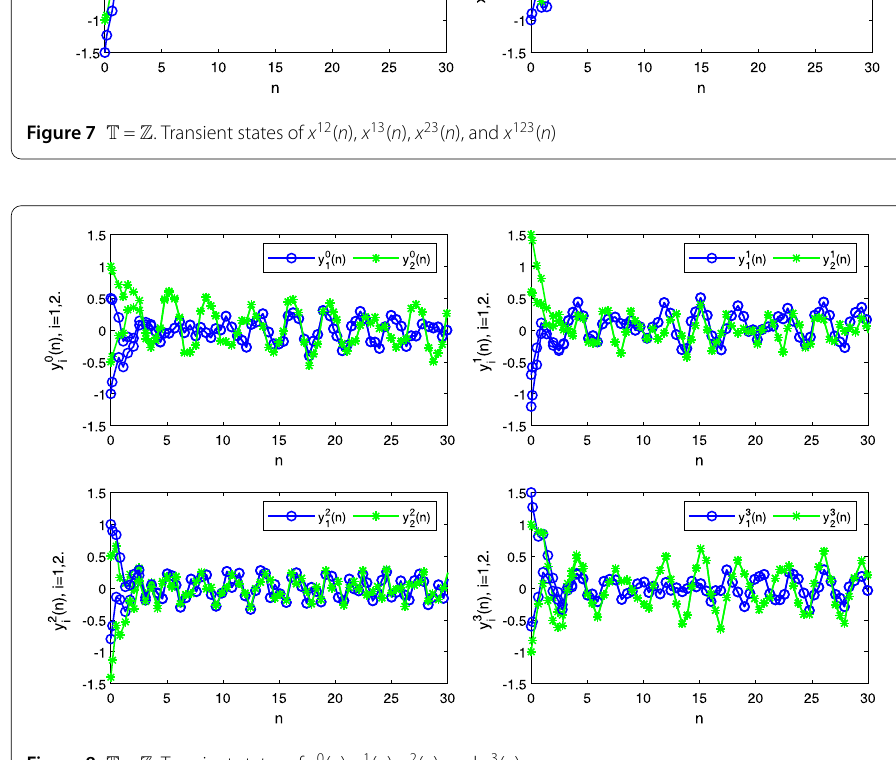
Figure 8 T = Z . Transient states of y 0 ( n ), y 1 ( n ), y 2 ( n ), and y 3 ( n )